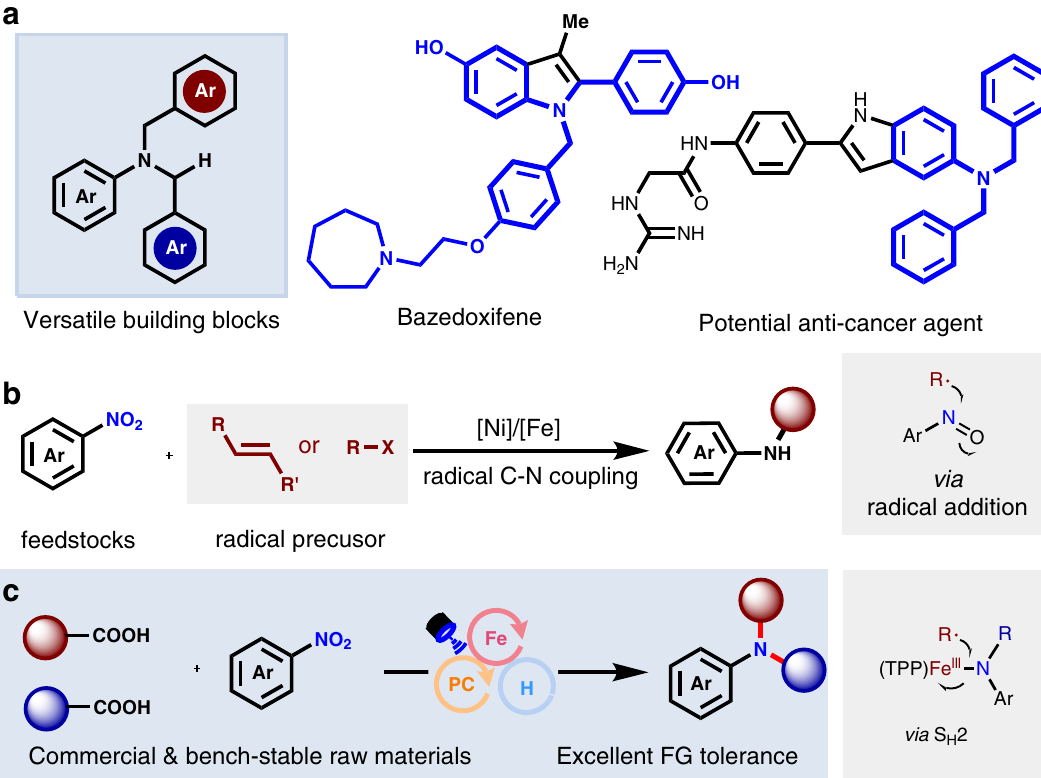
Fig. 1 Summary of previous and current studies. a The signi fi cance of aromatic benzylic tertiary amines. b Recent radical progress on catalytic synthesis of secondary amines with cheap nitroarenes. c Synergistic catalytic tertiary amines synthesis from commercially abundant feedstocks, cheap nitroarenes, and carboxylic